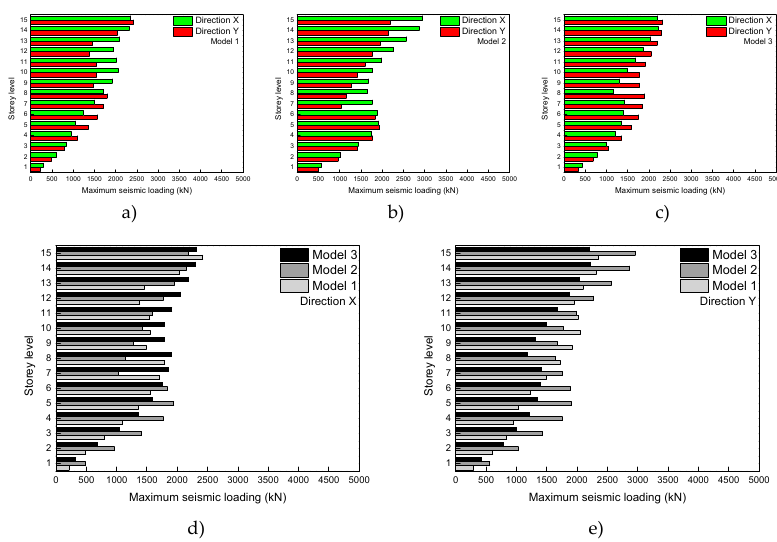
Figure 20. Linear elastic dynamic analysis result: maximum seismic loading envelope a ) Model 1; b ) Model 2; c ) Model 3; d ) global comparison (Direction X); and e ) global comparison (direction Y).